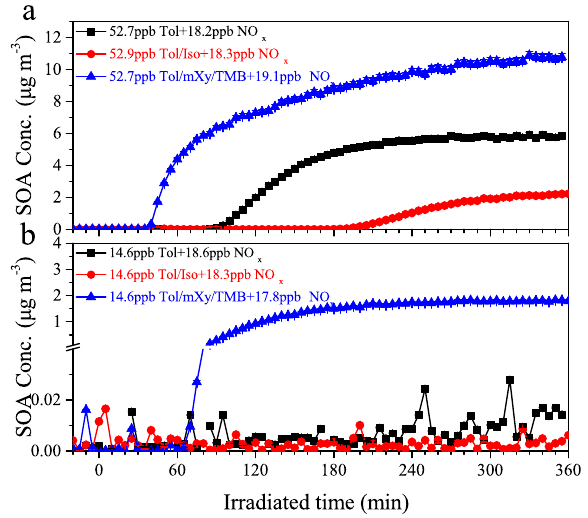
Fig. 1 Time series of SOA concentrations. SOA concentrations formed from photo-oxidation under different mixed VOC scenarios (i.e., toluene alone, mixed toluene and isoprene, as well as mixed toluene, m-xylene, and 1,3,5-trimethylbenzene) in the presence of NO x (~20 ppb) at a higher and b lower VOC concentration levels. The detailed experimental conditions can be found in Table 1.